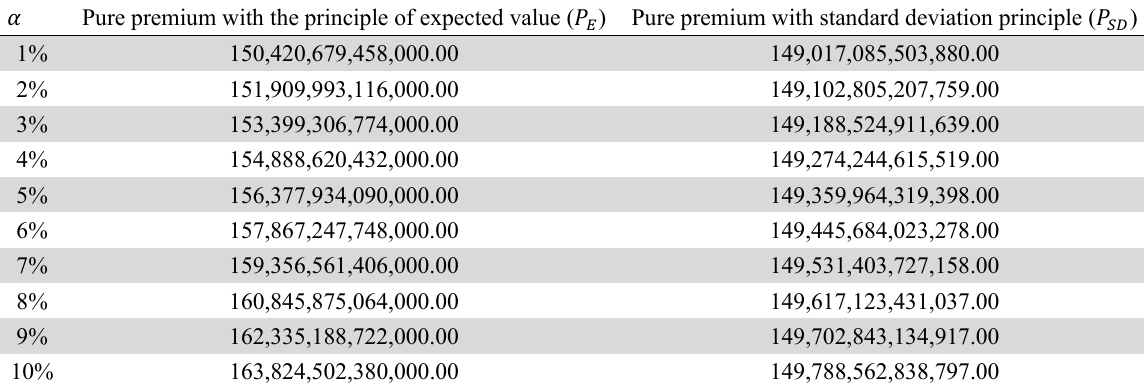
(cid:3020)(cid:3005)